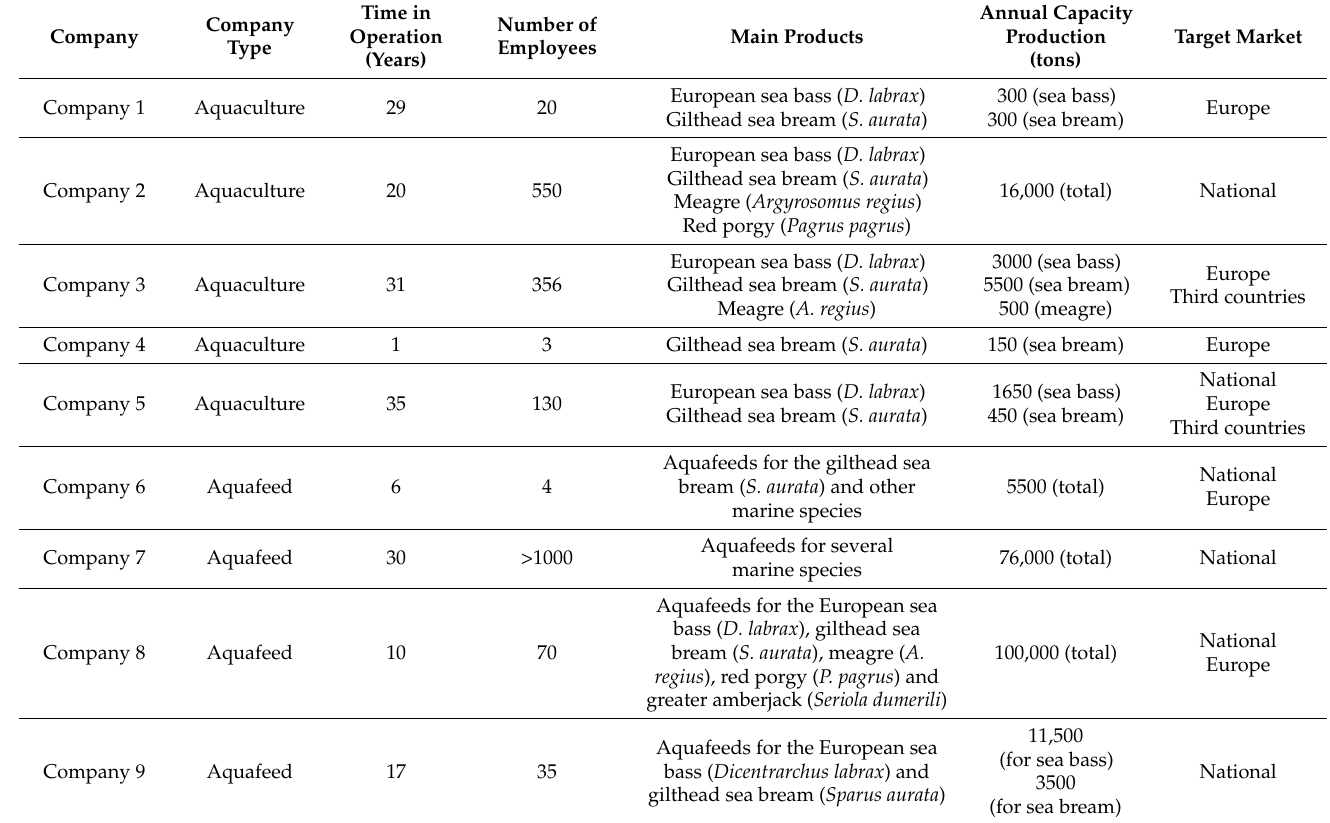
Table 2. Characteristics of the aquaculture and aquafeed companies that participated in the